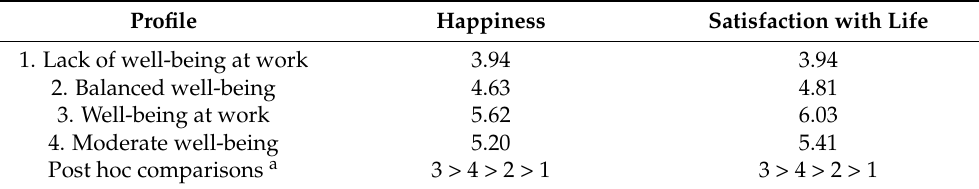
Table 7. Means associated with four-profiles model